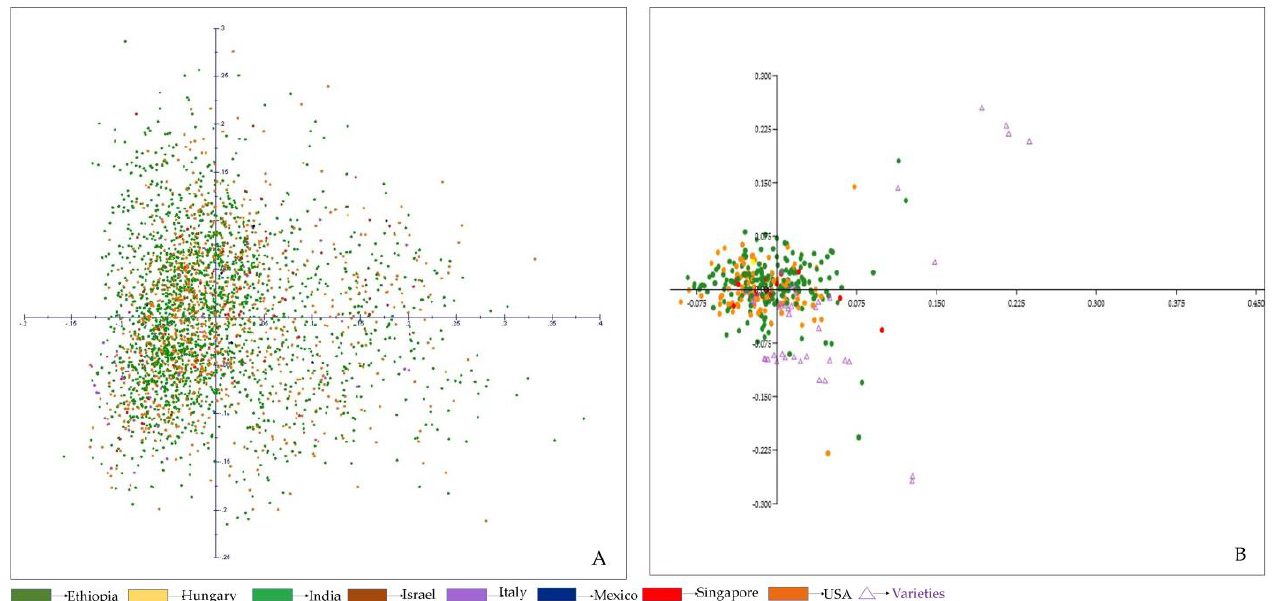
Figure 3. Principle component analysis (PCA). ( A ) PCA of entire collection with selected varieties. ( B ) PCA of core collection (10%) with selected varieties.